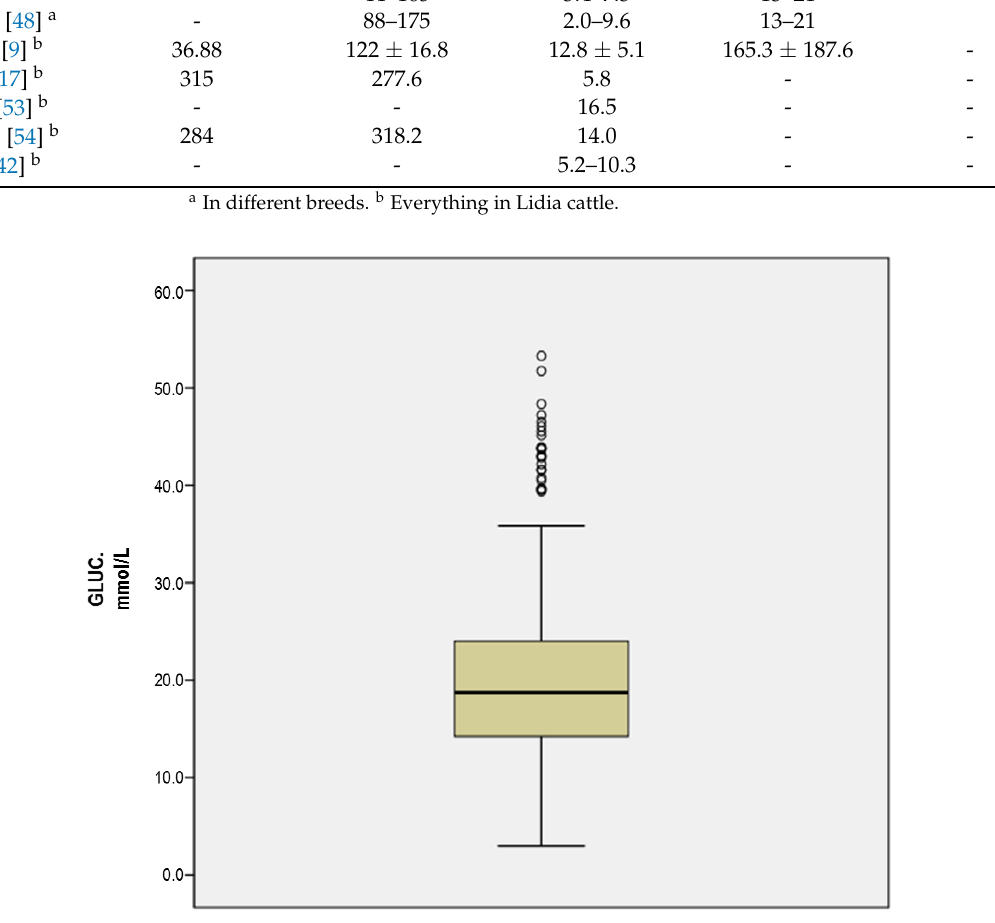
Figure 1. Graphic representation of the glycemia (mmol/L) of bulls after physical exercise. Table 3. Summary statistics of some enzymes (IU/L) in Lidia bulls’ plasma. Values found by other authors are also shown, both in Lidia breed and in other